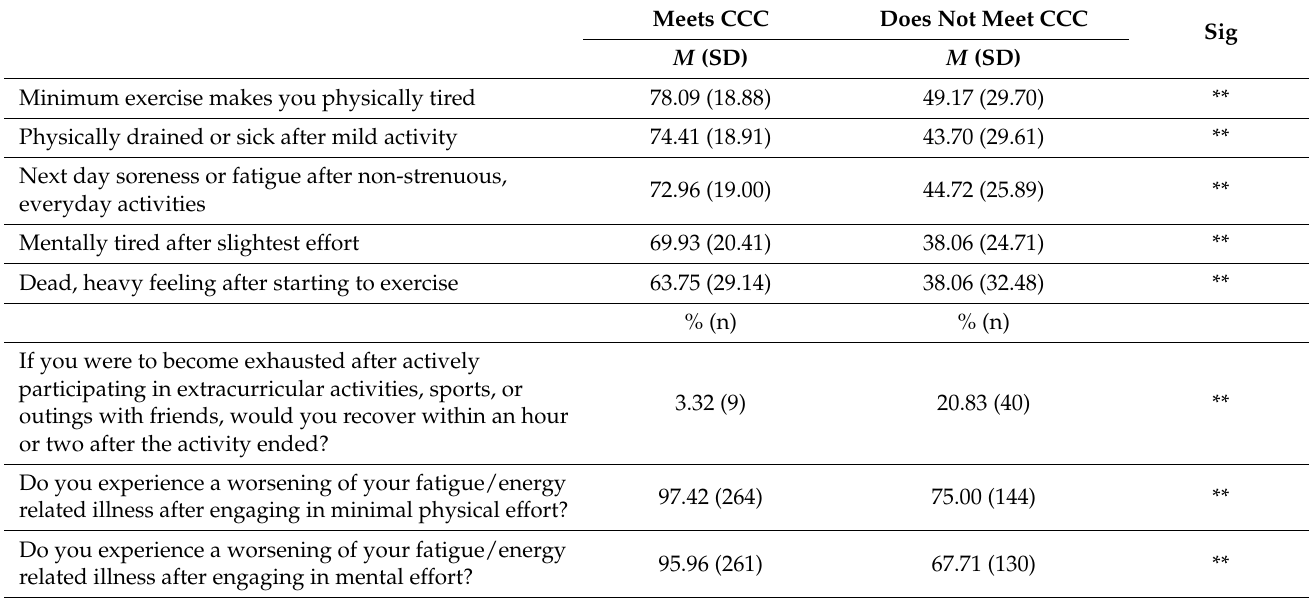
Table 4. DSQ-PEM symptom means and standard